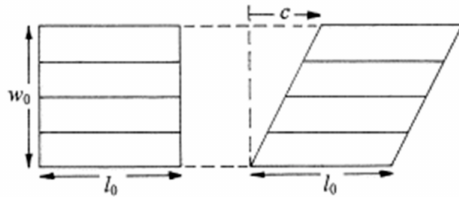
Figure 2. Assumptions of the simple shear deformation behavior of unidirectional fiber reinforcements: constant fiber length l 0 and constant fiber distance (from